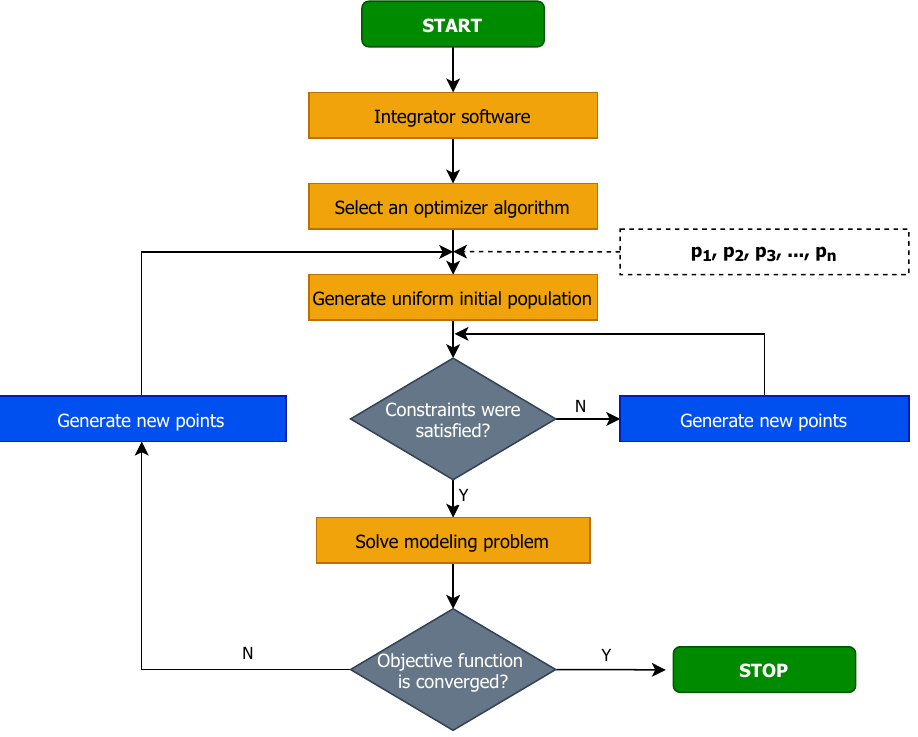
Figure 2. General flowchart for OAs, considering the main steps of the optimization